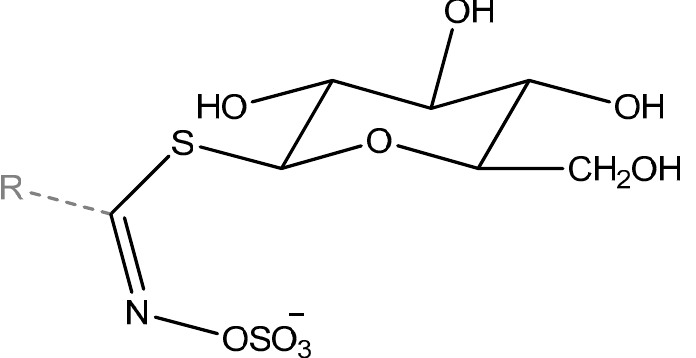
Figure 3. Structure of GLSs; R expresses side